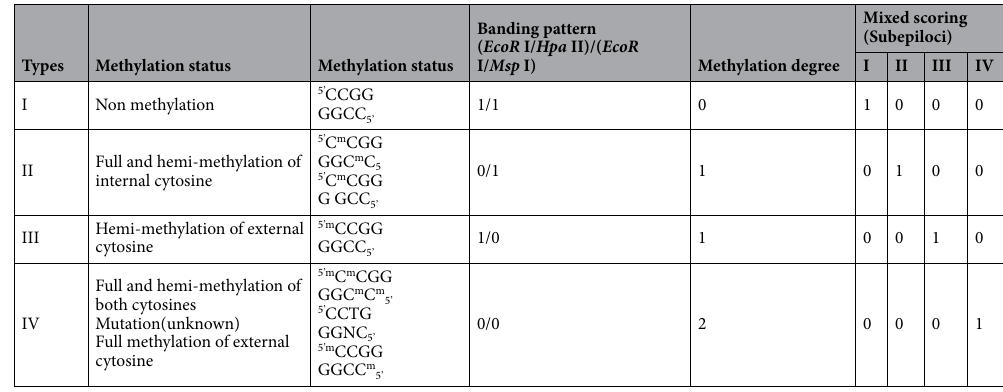
Table 8. Four DNA methylation types, their degrees and modified mixed scoring